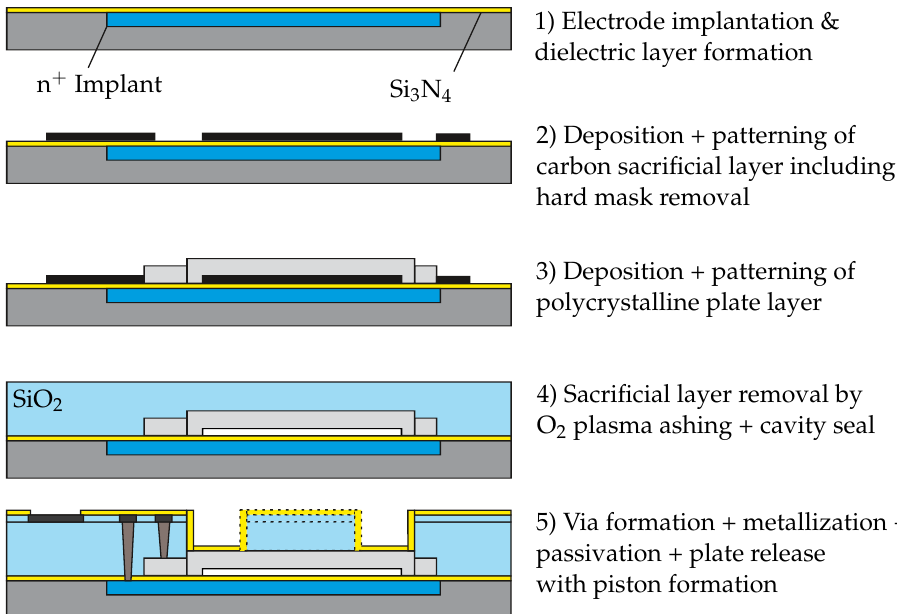
Figure 2. Surface micromachining process flow scheme of CMUT fabrication including a piston structure on top of the movable plate.